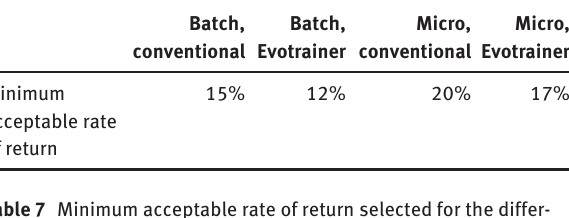
Table 7 Minimum acceptable rate of return selected for the differ- ent cases.